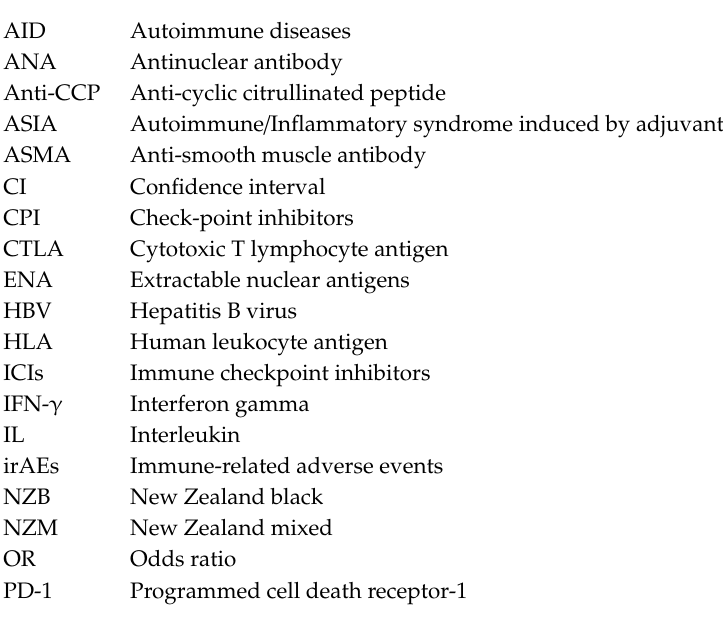
Table S1: HLA genotypes influencing sarcoidosis clinical presentation and prognosis; Table S2: Summary of major animal studies of probiotic interventions, their mechanism of action and their outcomes related to ASD; Table S3: Summary of major clinical studies of probiotic interventions, their mechanism of action and their outcomes related to